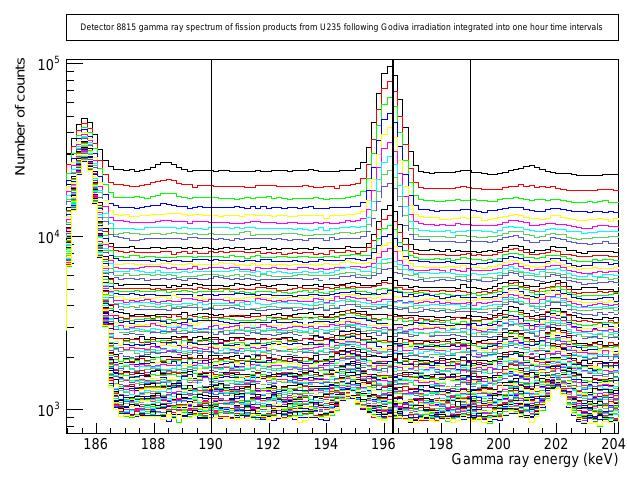
Figure 1. 88 Kr γ -ray cascade plot for the 196 keV γ -ray